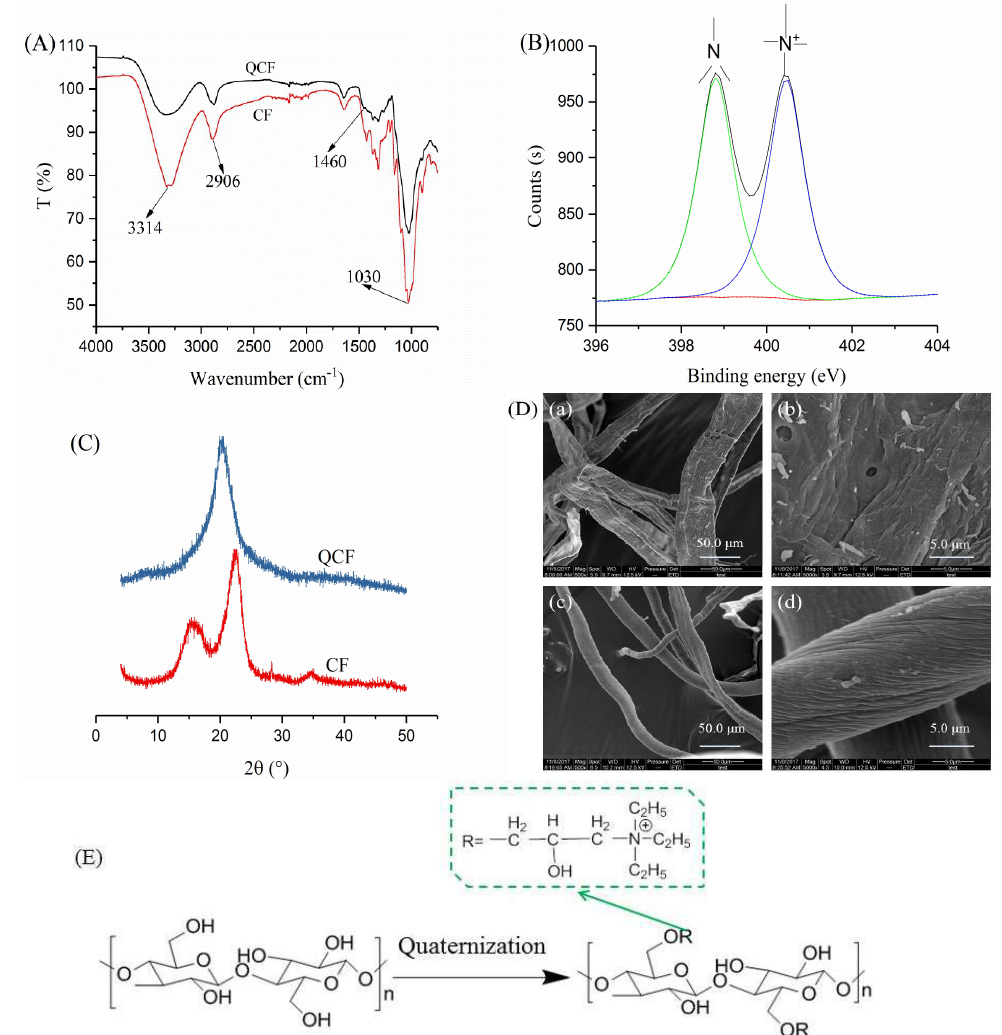
Figure 2. ( A ) FTIR spectra of CF and QCF; ( B ) N1s spectrum of QCF; ( C ) XRD patterns of CF and QCF; ( D ) SEM photographs of CF (( a ) ×500, ( b ) ×5000) and QCF (( c ) ×500, ( d ) ×5000); and ( E ) the chemical structure of QCF.